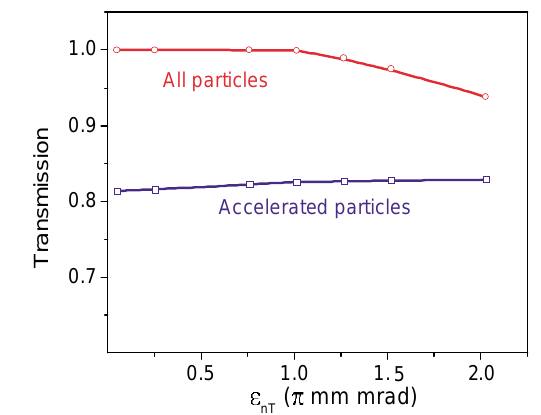
FIG. 9. (Color) Transmission as a function of the input trans- verse emittance. The red curve represents all particles at the end of the RFQ.